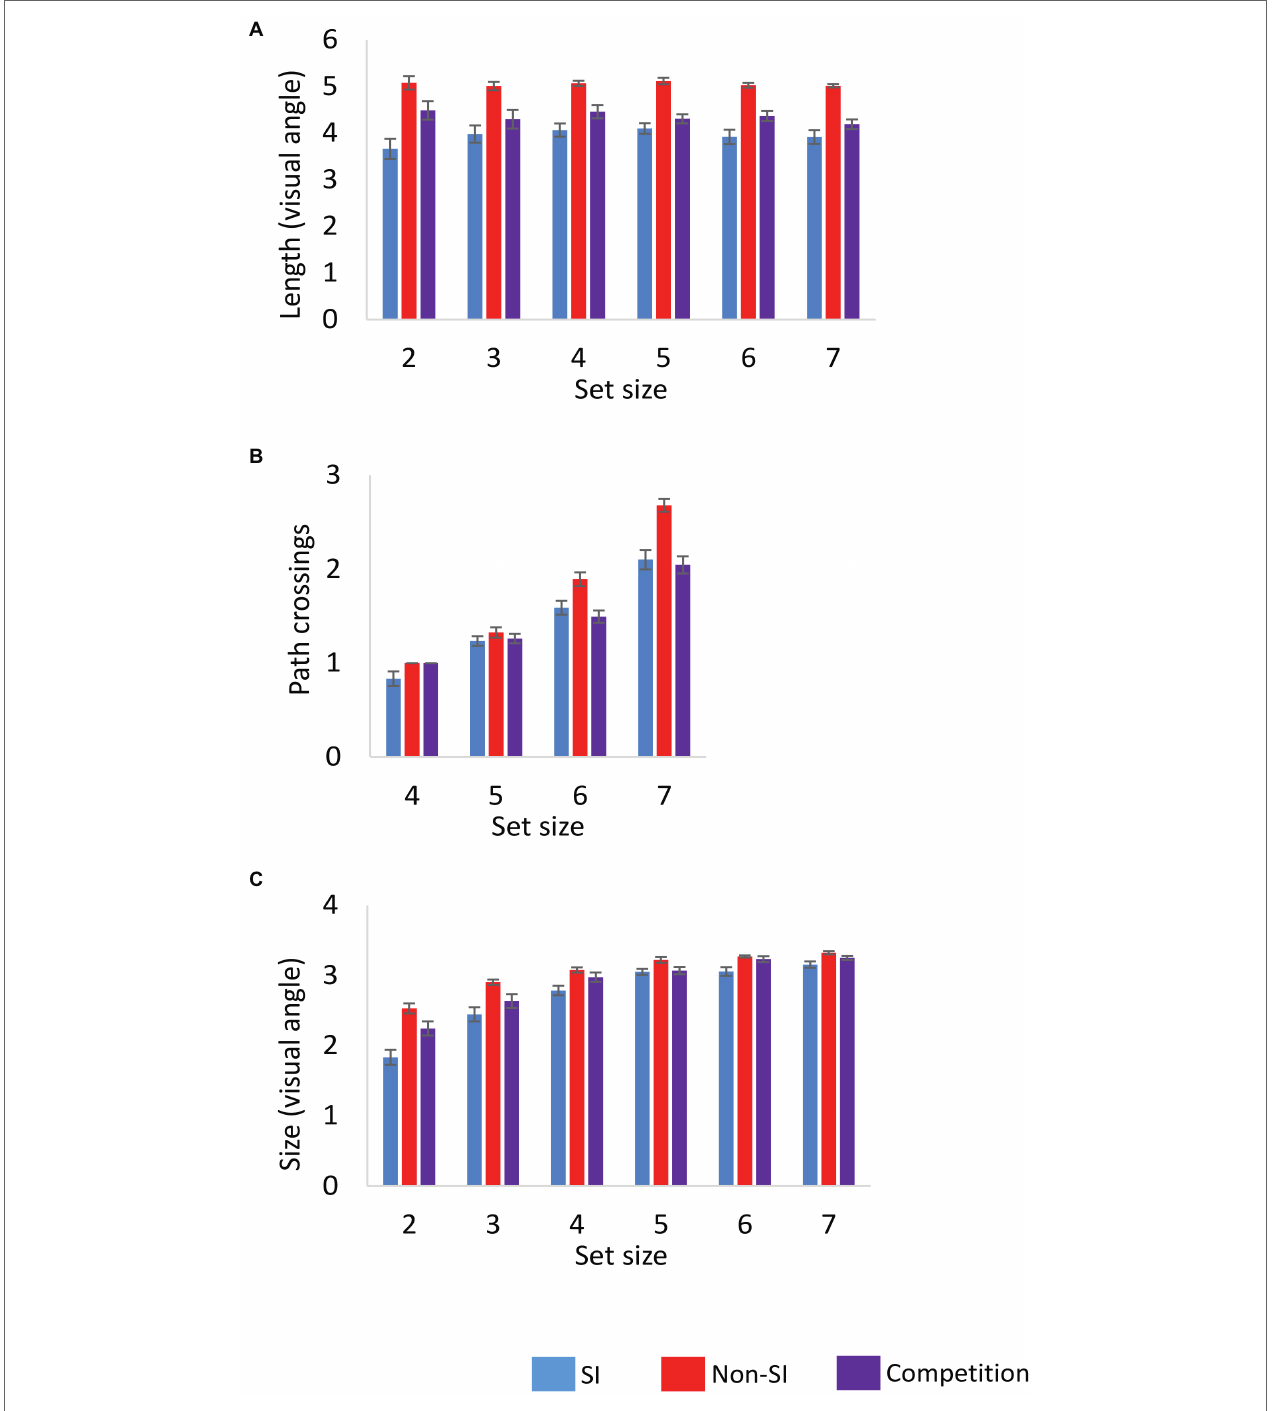
FIGURE 3 | Characteristics of the spatial configurations as a function of encoding condition and set size in Experiments 1 and 2: (A) the mean path length, (B) the number of path crossings, and (C) configuration size. Error bars represent standard error of the mean. SI,